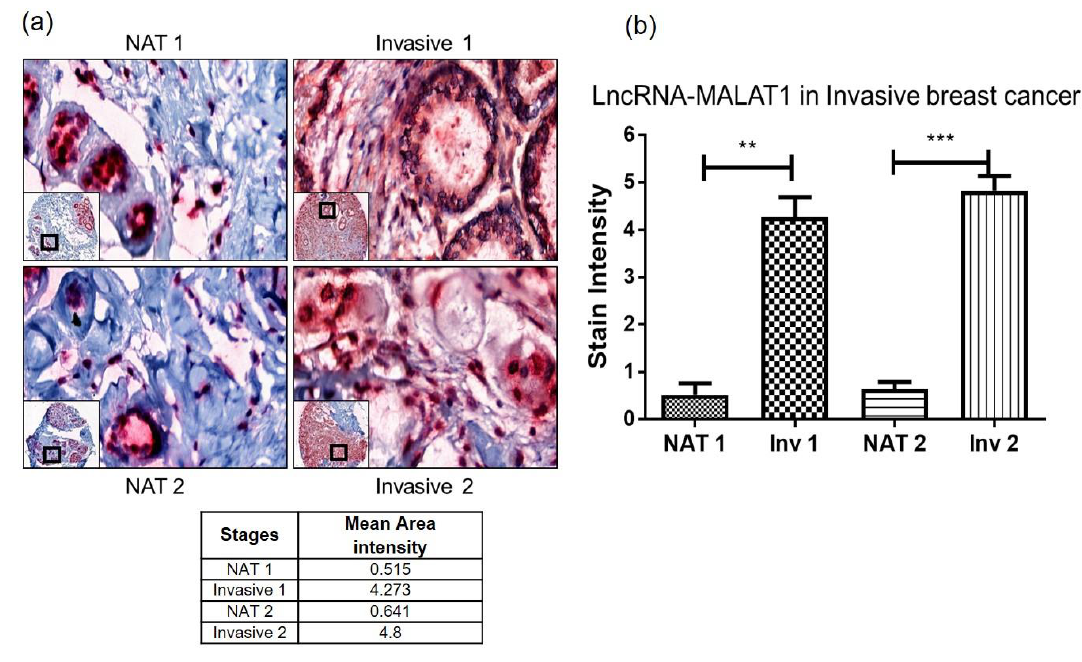
Figure 5. LncRNA MALAT1 expression in breast cancer. BioMax TMA BR243w containing 12 normal adjacent tumor (NAT) and 12 invasive breast carcinomas were stained and analyzed. ( a ) Matched breast cancer tissues (NAT vs. Invasive) from two different patients, 1 and 2, were stained for lncRNA MALAT1 using Z probe. The invasive breast cancer tissues have higher staining for lncRNA MALAT1 as compared to normal adjacent tumors. ( b ) Quantitation of the lncRNA MALAT1 staining intensity was performed using Image J software. 10× (inset) and 80× magnification using CaseViewer 2.2 software, scanned and analyzed on Pannoramic 250 Flash III. Statistical analysis: Unpaired t -test, ** p < 0.01, *** p < 0.001.